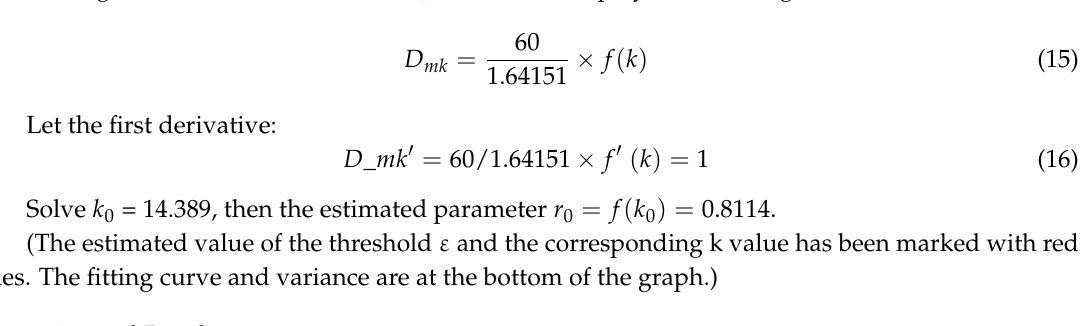
Table 1. The segmentation results using different ε for airborne laser scanning data using X , Y , Z fields.